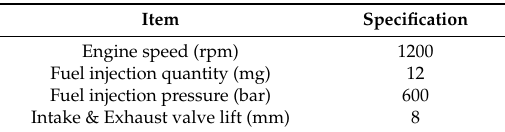
Figure 3. Predictive model correlation with experiment data. ( a ) Pressure and Heat Release Rate; ( b ) Pilot injection rate; ( c ) Main injection rate. Table 4. Engine operating condition.